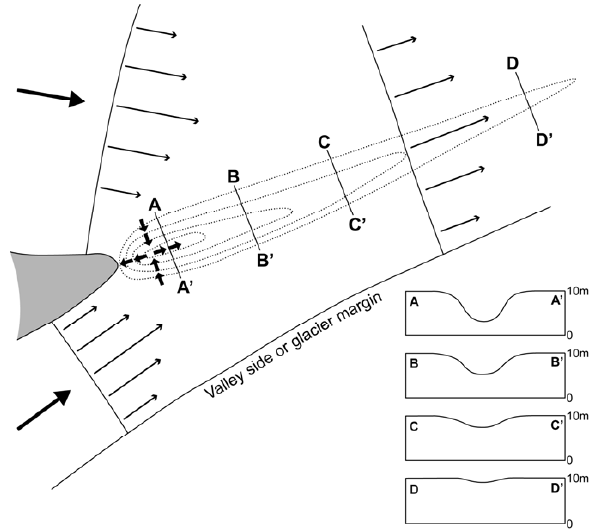
Fig. 8. Schematic illustration of the formation of longitudinal sur- Figure 8. Schematic illustration of the formation of longitudinal surface face structures at the confluence of two glaciers. The confluence structures at the confluence of two glaciers. The confluence area is marked by area is marked by strong transverse convergence and a concomitant strong transverse convergence and a concomitant longitudinal extension in longitudinal extension in the horizontal plane. This creates a sur- face depression or hollow at the confluence, indicated here by the the horizontal plane. This creates a surface depression or hollow at the contour lines (dashed lines). Cross-profiles A-A’ to D-D’ indicate confluence, indicated here by the contour lines (dashed lines). Cross-profiles the expected ice-surface morphology. The downstream extent of the A-A’ to D-D’ indicate the expected ice-surface morphology. The downstream flow stripe is determined by the time it takes the hollow to be filled in by transverse compression, and the distance travelled over the extent of the flow stripe is determined by the time it takes the hollow to be same time. The hollow can also be filled in by drifting snow or by filled in by transverse compression, and the distance travelled over the same differential time. The hollow can also be filled in by drifting snow or by differential ablation.